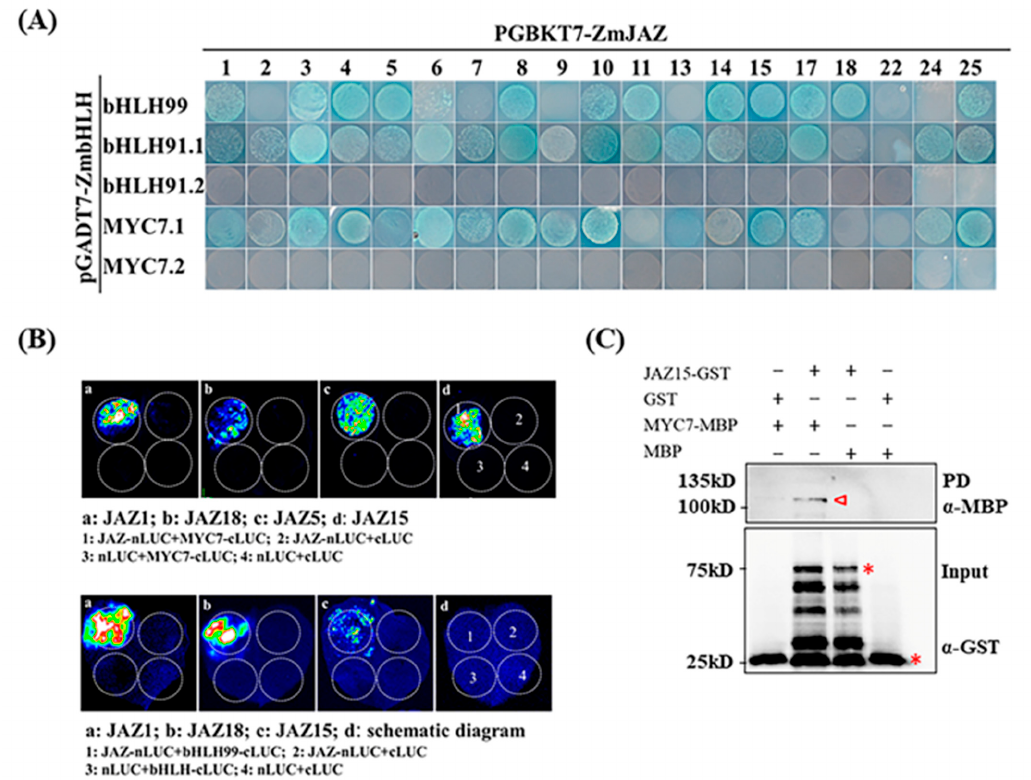
Figure 4. Identification of interactions between JAZs and bHLHs. ( A ) Y2H assay to screen the interaction between all JAZs and bHLH99, bHLH91 and MYC7 proteins. bHLH91.1 represents the N-terminus of bHLH91 while bHLH91.2 represents C-terminus. MYC7.1 represents the N-terminus of MYC7 and MYC7.2 for C-terminus. ( B ) Split-luciferase assay confirming the interactions between selected JAZs and MYC7 (top panels) and bHLH99 (bottom panels). Panel pictures in a, b and c represent different JAZ members to be tested with either MYC7 or bHLH99, and d is the schematic diagram for different combination of the vectors. C , Pull-down assay confirming the interaction between JAZ15 and MYC7. The assay was conducted using 2 µg COI1-MBP and JAZ-GST fusion protein each reaction in the presence of 20 µL GST beads. The bands marked in red triangle in top panel shows the signal identified by MBP antibody, and the bands marked in red star in bottom panel shows the input of JAZ-GST fusion protein and GST protein using GST antibody.